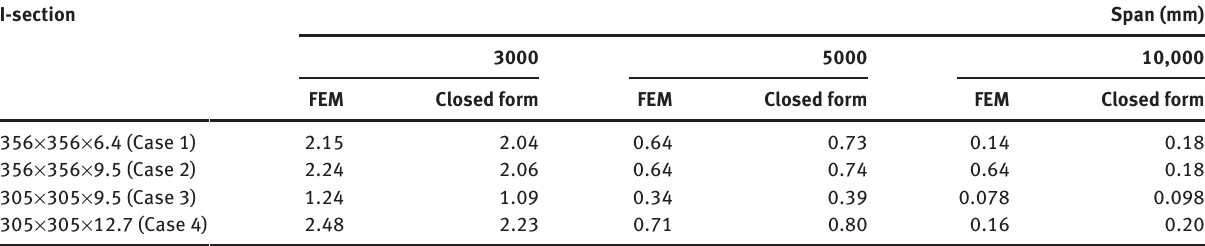
Table 10 Effect of the web (or flange) thickness on the normalized critical buckling stresses for I-shaped section.